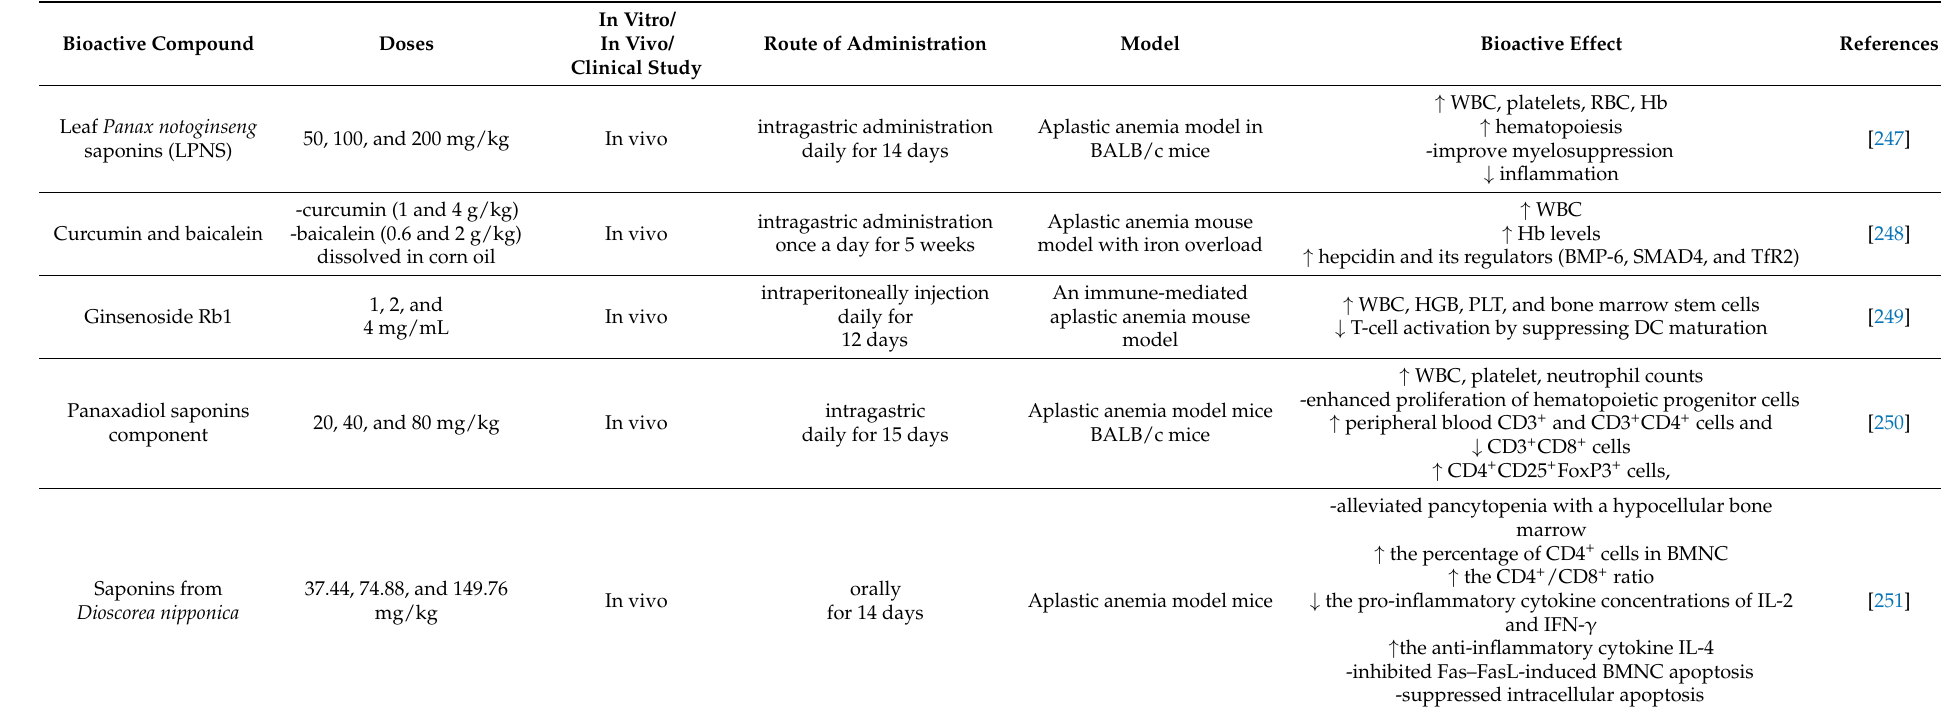
Table 7. Pharmacological effects of natural antioxidants in aplastic anemia